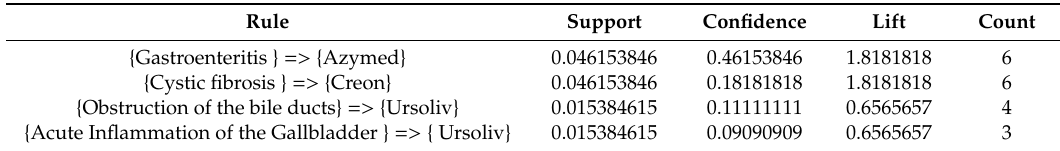
Table 4. Associative rule